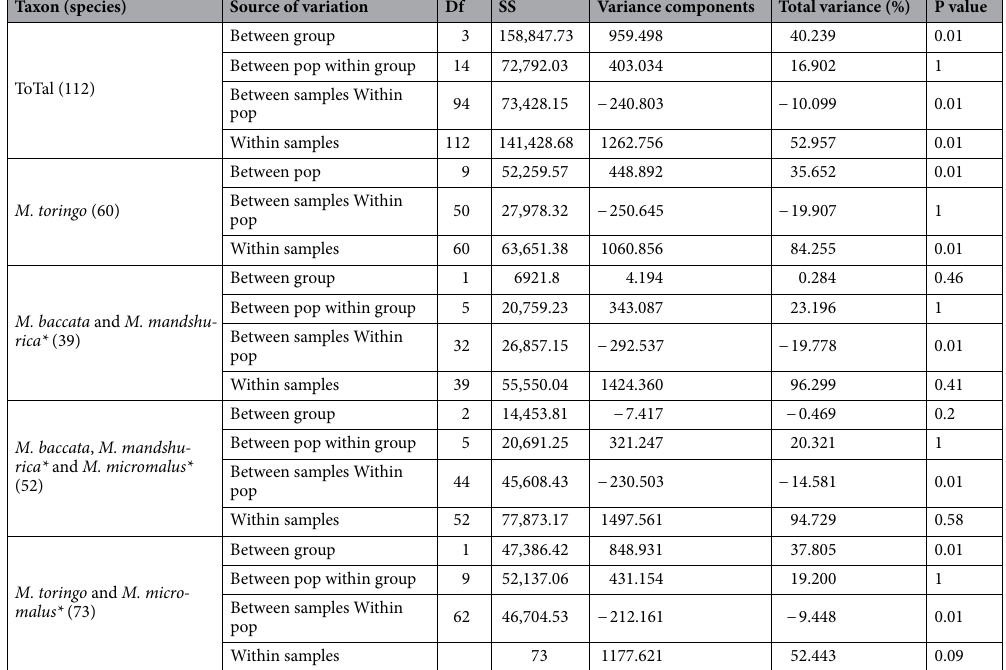
Table 3. Summary on the analyses of molecular variance (AMOVA) in Malus and its relatives across 8426 SNPs, showing degree of freedom (df), sum of squares (SS), variance components, and the total variance contributed by each component (%) and its P value. Asterisked scientific name included SRA and collected